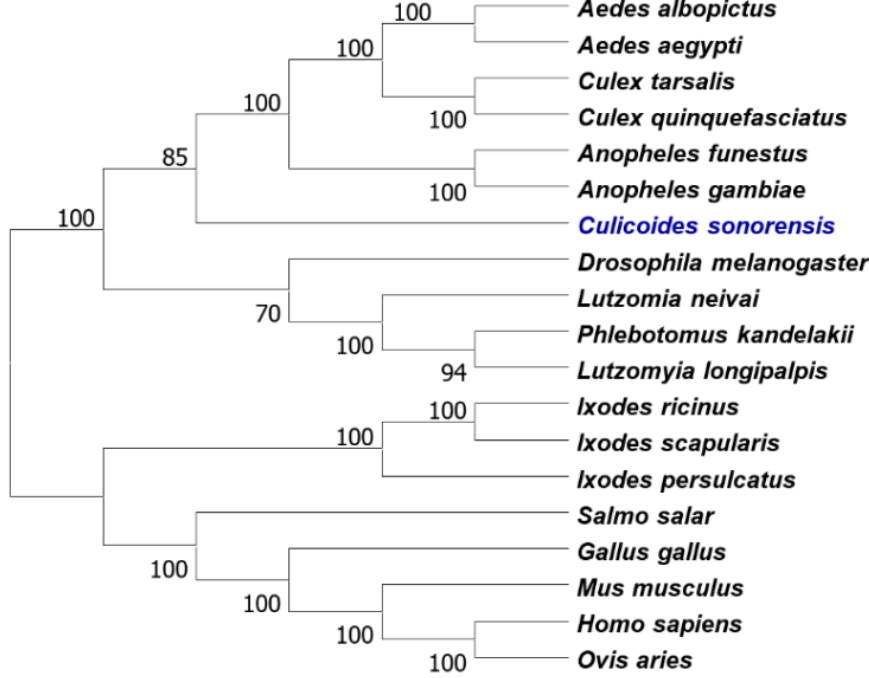
Figure 1. A neighbour-joining phylogenetic tree constructed using MEGA X, showing the clustering of Culicoides sonorensis 3-hydroxy-3-methylglutaryl-CoA (HMG-CoA) reductase amongst insect HMG-CoA reductase enzymes. Accession numbers of sequences used to construct the tree are provided in supplemental Table S1.